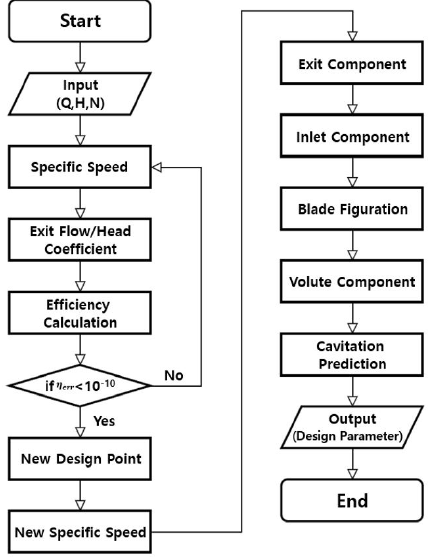
Figure 2. Process of ultra-low specific speed centrifugal pump